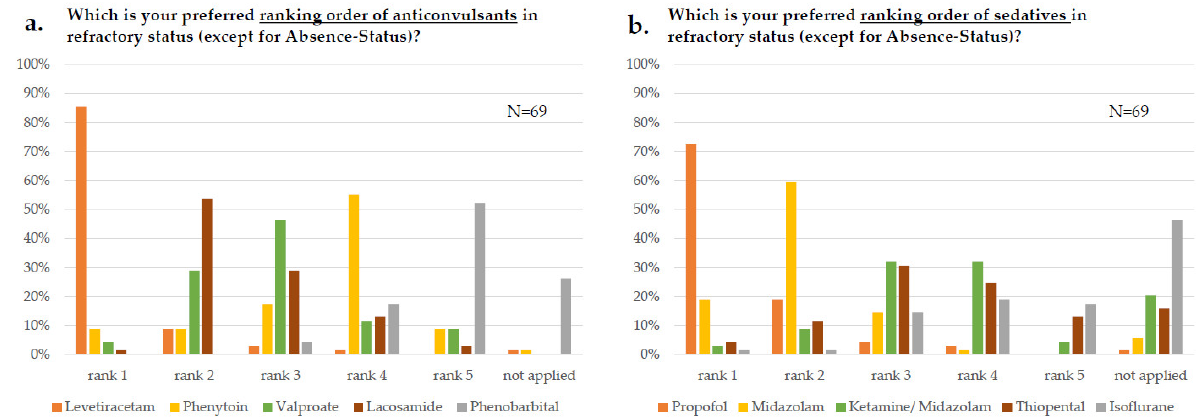
Figure 4. Anticonvulsants and sedatives in status epilepticus (SE). ( a ) Ranking order of anticonvulsants ( b ) Ranking order of sedatives. Participants were asked to put the five substances marked by different colors into a ranking order. Multiple answers were not allowed. Data are displayed as percentage of survey participants answering this question. N = number of respondents.